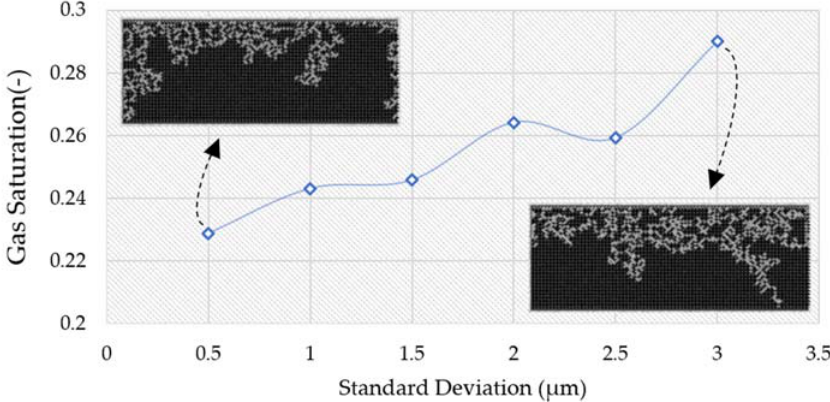
Figure 10. Gas saturation at breakthrough of the gas phase for di ff erent PSDs. The mean value of throat sizes is 17 μ m. Table 3. Total void volumes and porosities associated with the gas saturation at breakthrough.